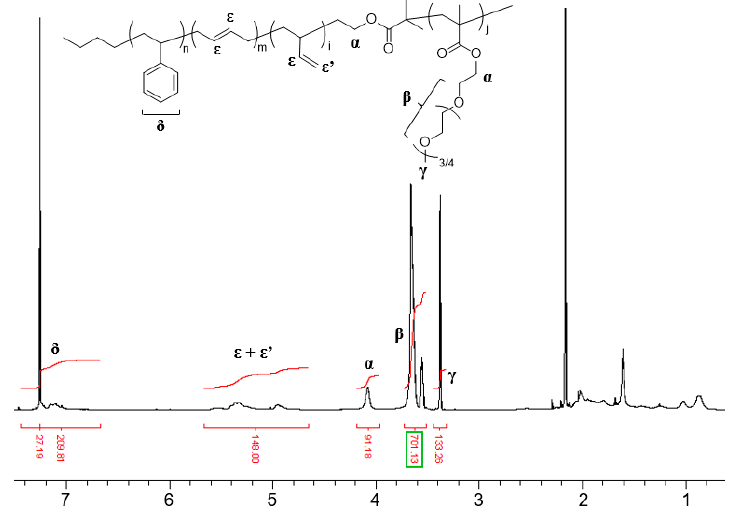
Figure 12. 1 H-NMR spectrum of SBR- b -PEGMA.